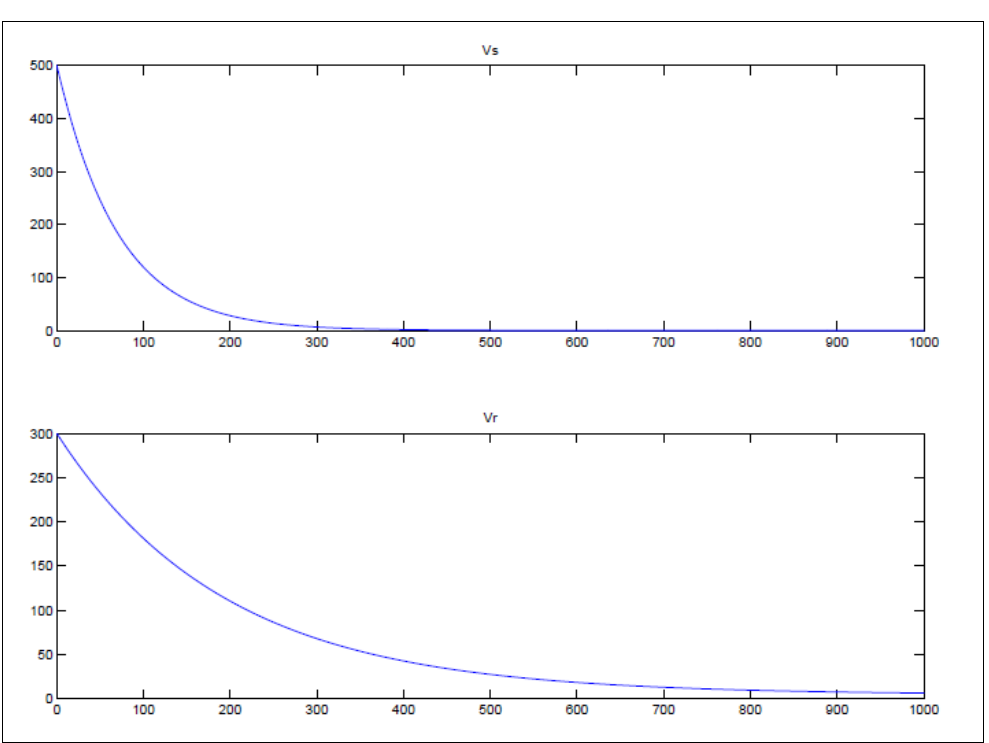
Figure 8. Sensitive and resistant viruses dynamics (nonconcave